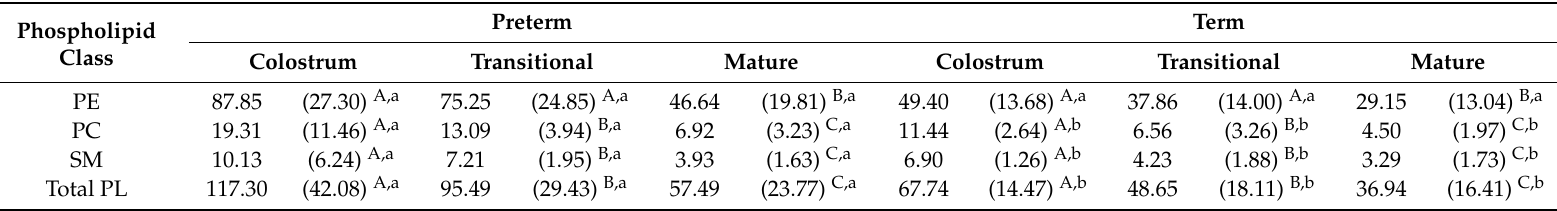
Table 1. Concentration of phospholipids (mg/100 mL) in colostrum, transitional and mature milk from mothers with preterm and term gestations.